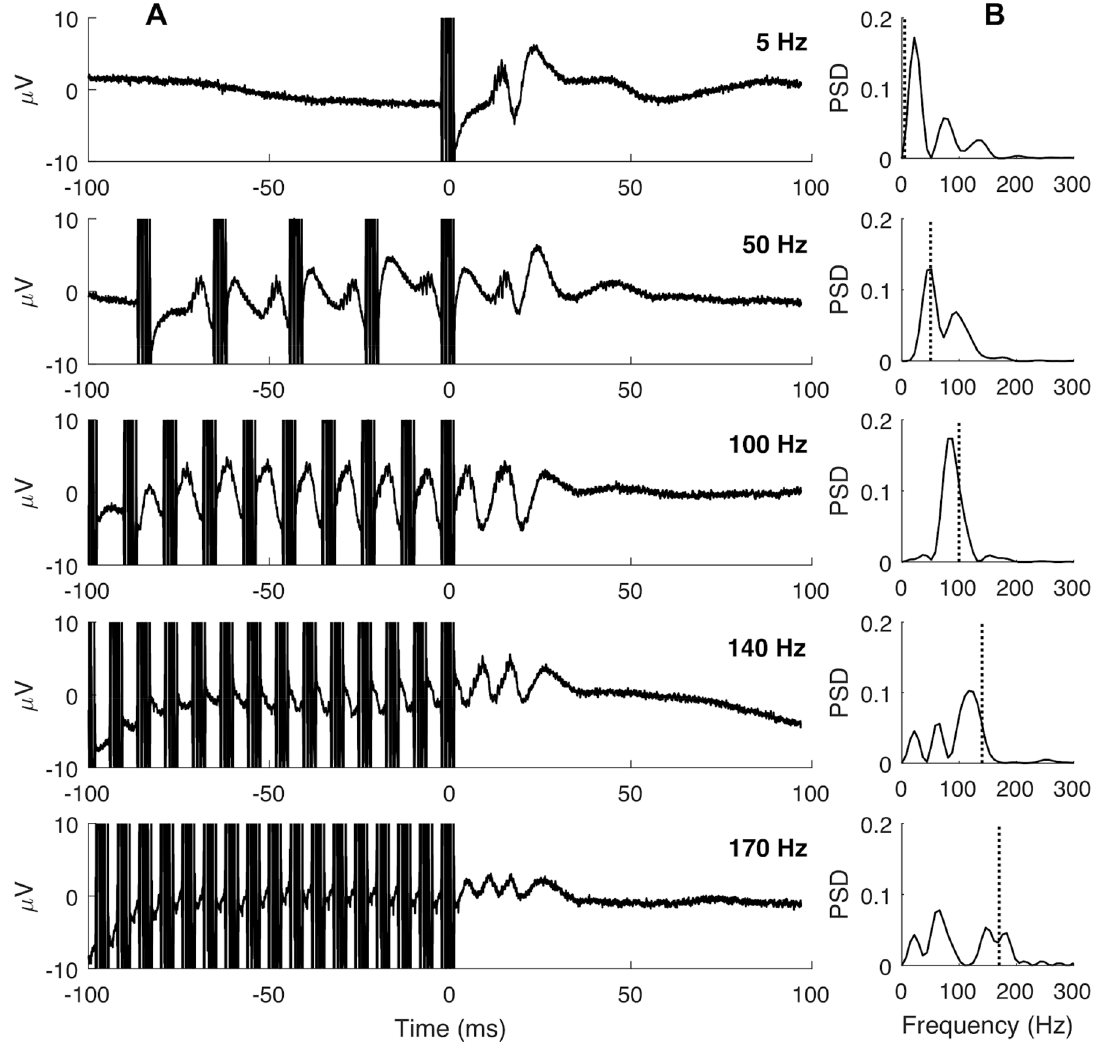
Figure 4. EP in response to a single 5-Hz pulse (top row) and 50–170-Hz burst stimulation for a single VIM contact in a single subject. ( A ) Average traces for the 100-ms stimulation period (negative time values) and the 100-ms EP response used for analysis (positive time values). Stimulation artifacts appear as thick vertical lines. ( B ) Power spectral density (PSD) calculated from the 100-ms period after the last stimulus pulse. Dotted line indicates stimulation